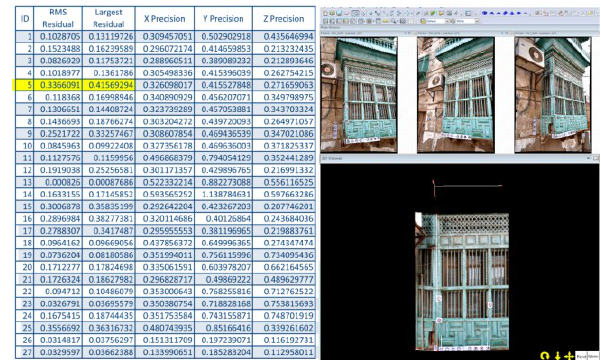
Figure 8.Table of RMS residual values in points-based project.